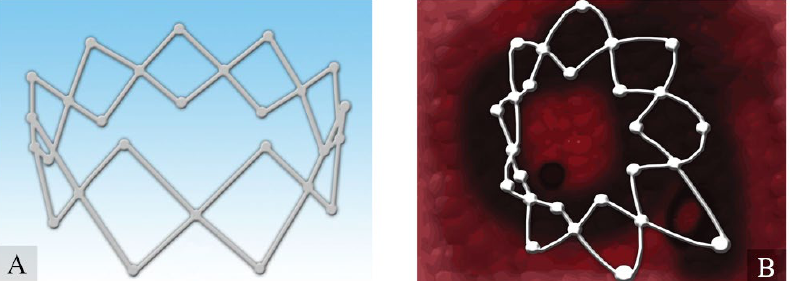
Figure 5. Mometasone-loaded ( A ) spring-like Propel™ sinus implant expands when placed into the sinus mucosa ( B ), thus keeping the middle meatus open and, hence, promoting mucous drainage and wound healing. Adapted from an open-access source: [15] .